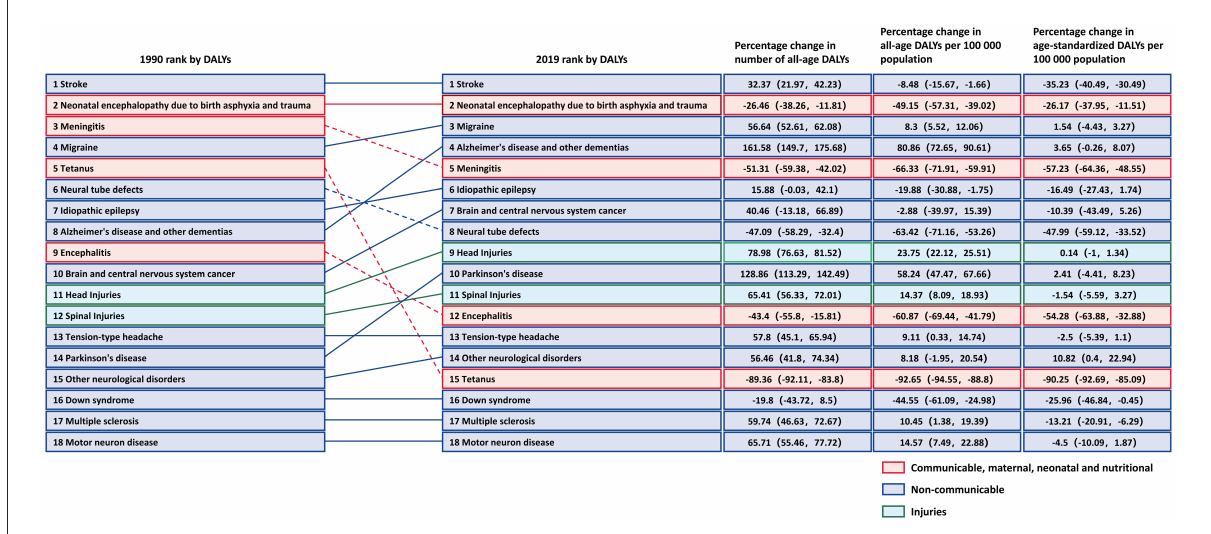
FIGURE1 Changes in rank and percentage of global DALYs, in terms of total DALYs, percentage change in numbers of DALYs and age-standardized DALY rates due to 18 neurological disorders for all ages and both sexes from 1990 to 2019. Solid lines indicate an increase in rank while dashed lines represent a decrease in